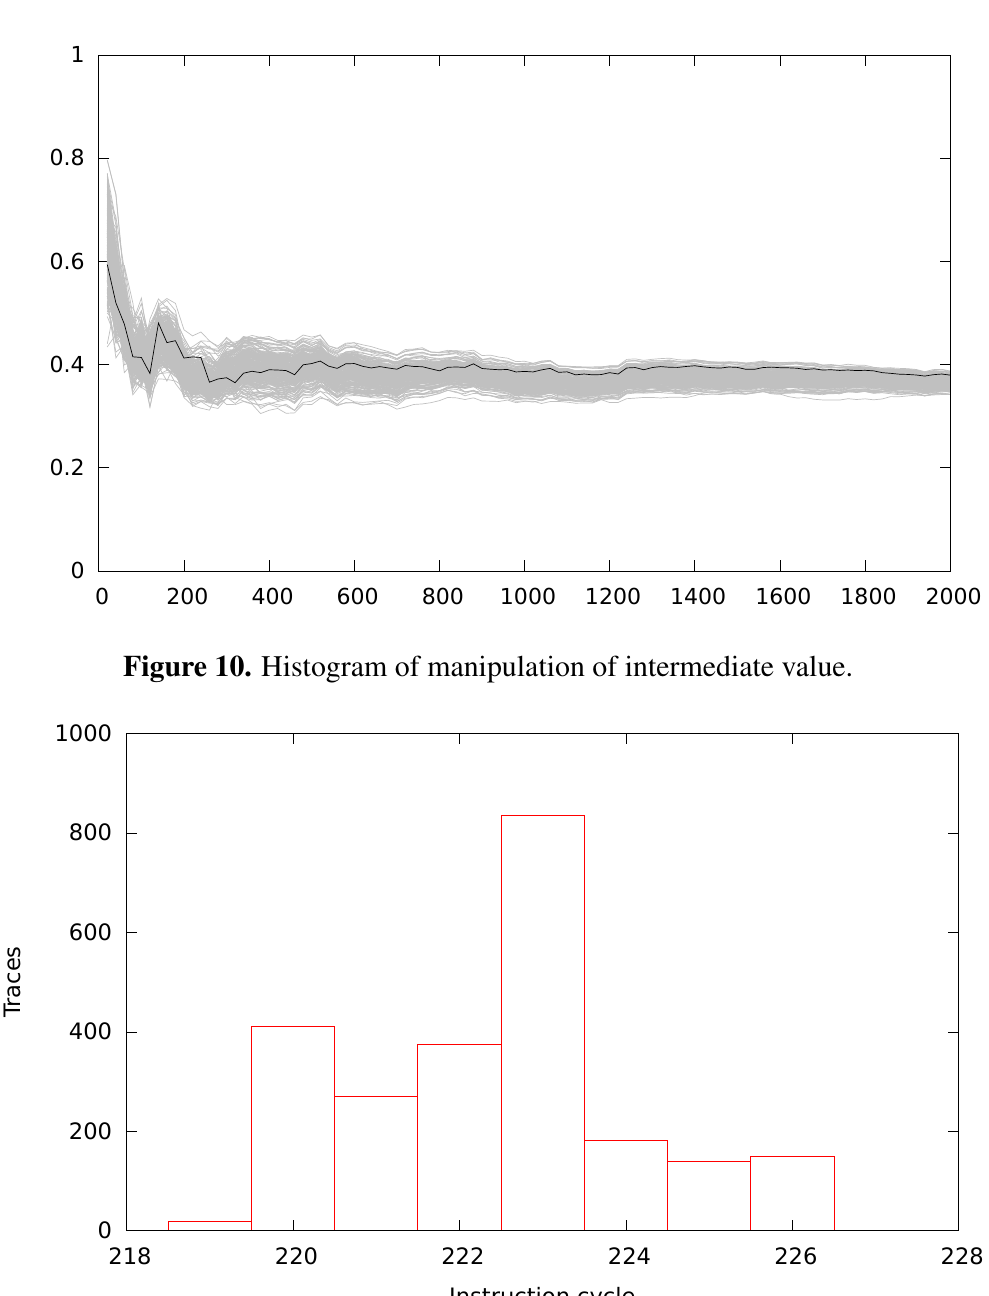
Figure 9. Maximum correlation for different key guesses vs . number of power traces when switching randomly between 3 implementations (2, 3 iterations and no unrolling).